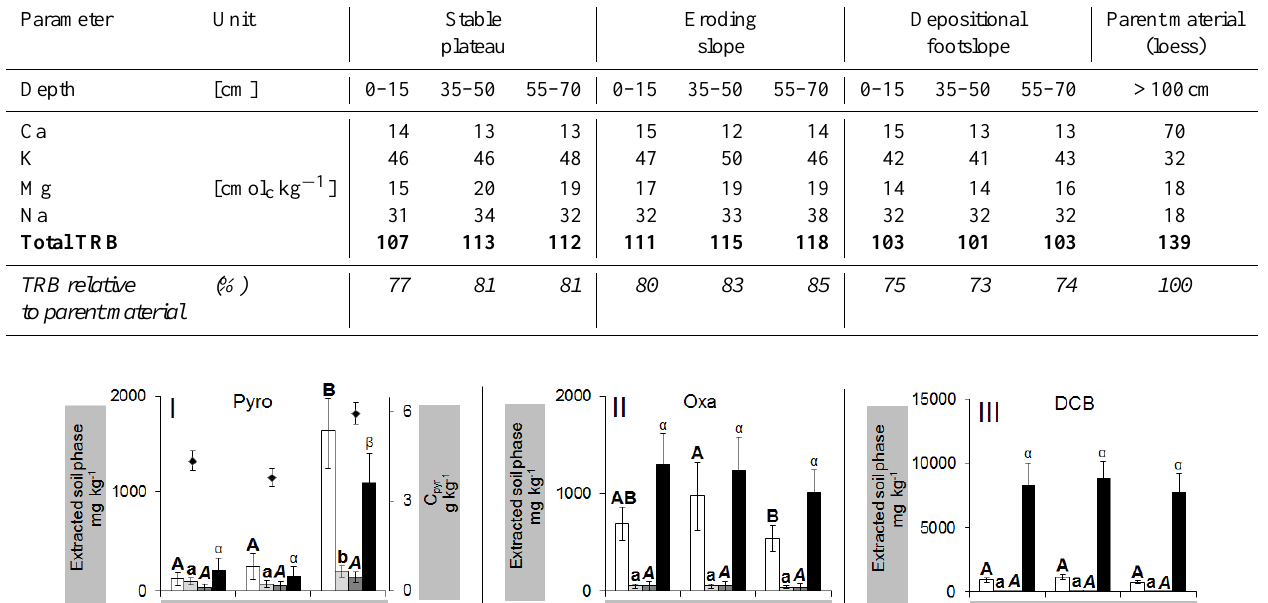
Table 2. Total Ca, K, Mg and Na content and TRB values for the soil profiles at several depths and for the parent material. Parameter Unit Stable Eroding